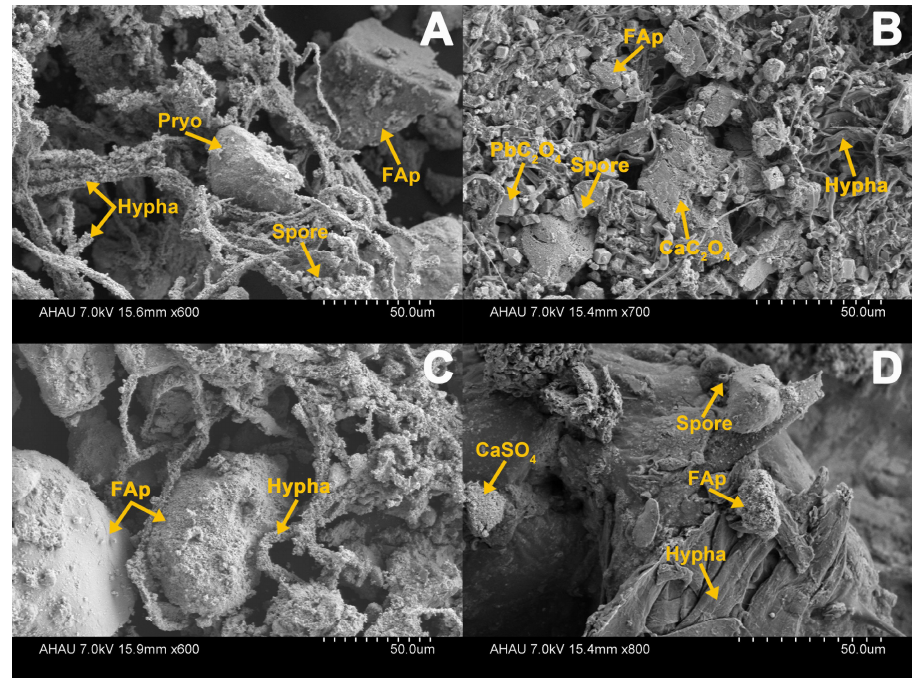
Figure 7. SEM image and EDS point data for ANG + FAp ( A ), ANG + NH 4+ + FAp ( B ), ANG + NO 3− + FAp ( C ), and ANG + urea + FAp ( D ) treatments after six days of incubation.